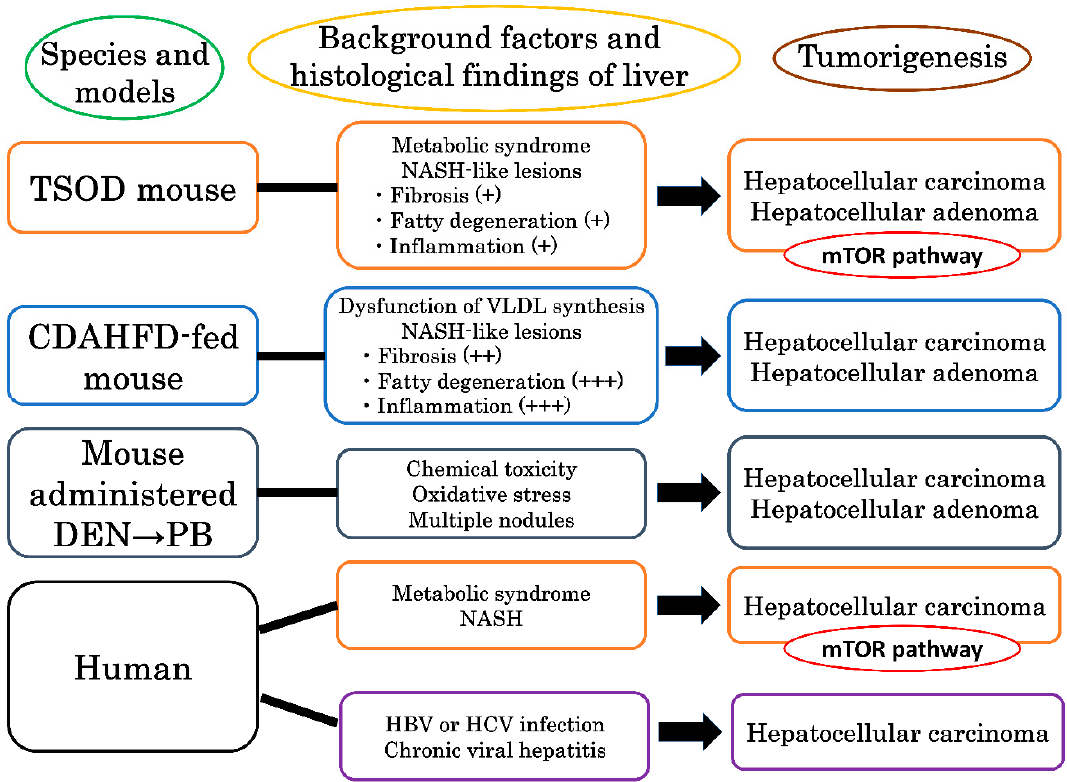
Figure 5. The mTOR pathway is characteristically activated in liver tumors associated with metabolic syndrome and NASH in both mice and humans. Table S1: Incidence and multiplicity data for hepatocellular adenomas (HCAs), hepatocellular carcinomas (HCCs) and total liver tumors in TSOD and CDAHFD-fed C57BL/6J mice, Table S2: Clinicopathological characteristics of patients with